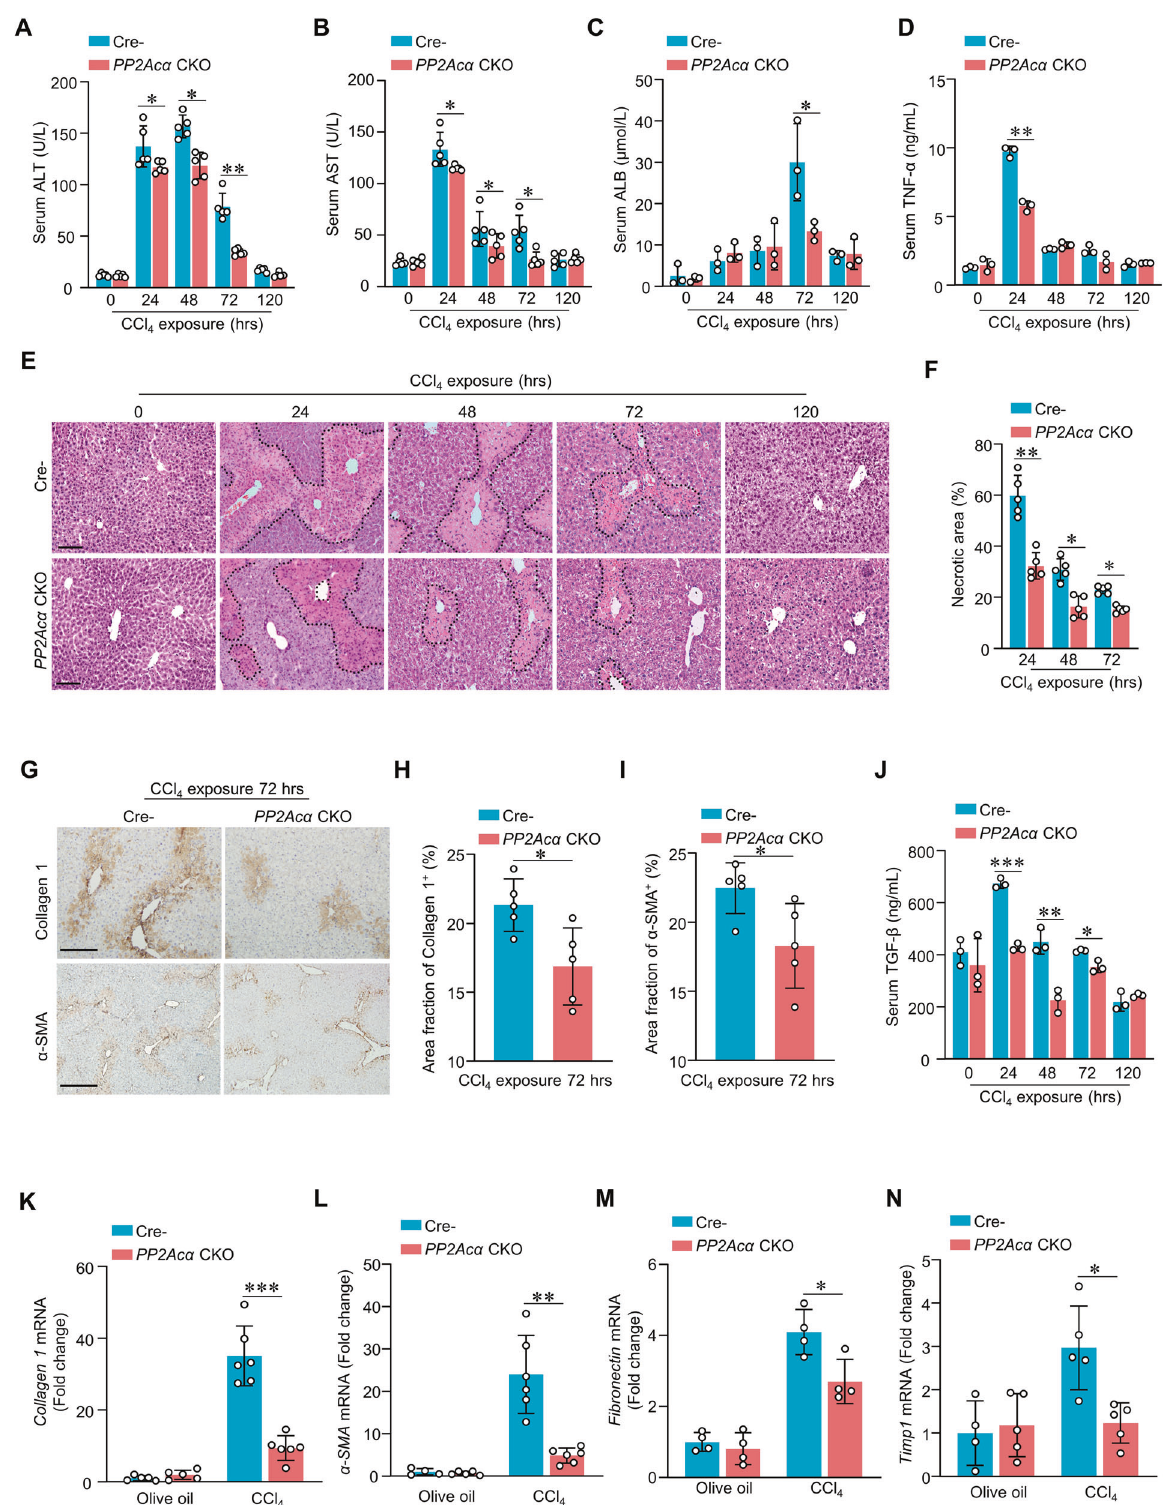
Fig. 5 De fi ciency of PP2Ac α in hepatocytes alleviated ALI. Serum ALT ( A ) ( n = 5), AST (B) ( n = 5), total bile acid ( C ) ( n = 3), and TNF- α levels ( D ) ( n = 3) were analyzed in CCl 4 -induced ALI model mice. ( E and F ) Representative images of H&E staining of liver ( E ) (scale bar, 100 mm) and quanti fi cation of liver necrotic areas ( F ) in Cre − and PP2Ac α CKO mice treated with CCl 4 from 0 to 120 h ( n = 5). Representative images of IHC staining of liver Collagen I and α -SMA ( G ) (scale bar, 100 mm) and quanti fi cation of liver Collagen I-positive area ( H ) ( n = 5) and α -SMA-positive area ( I ) ( n = 5) in Cre − and PP2Ac α CKO mice treated with CCl 4 72 h. Serum TGF- β levels were analyzed in CCl 4 -induced ALI model mice ( n = 3). qRT-PCR of relative fi brogenesis marker, Collagen I ( K ), α -SMA ( L ), Fibronectin ( M ), and Timp1 ( N ) mRNA levels in Cre − and PP2Ac α CKO mice treated with CCl 4 or olive oil. * p < 0.05, ** p < 0.01, *** p < 0.001, one-way ANOVA followed by Tukey ’ s multiple comparisons test ( A – D , F , J – N ); two-tailed Student ’ s unpaired t test ( H and I ). Data are represented as mean ± SD. Cell Death and Disease (2022)